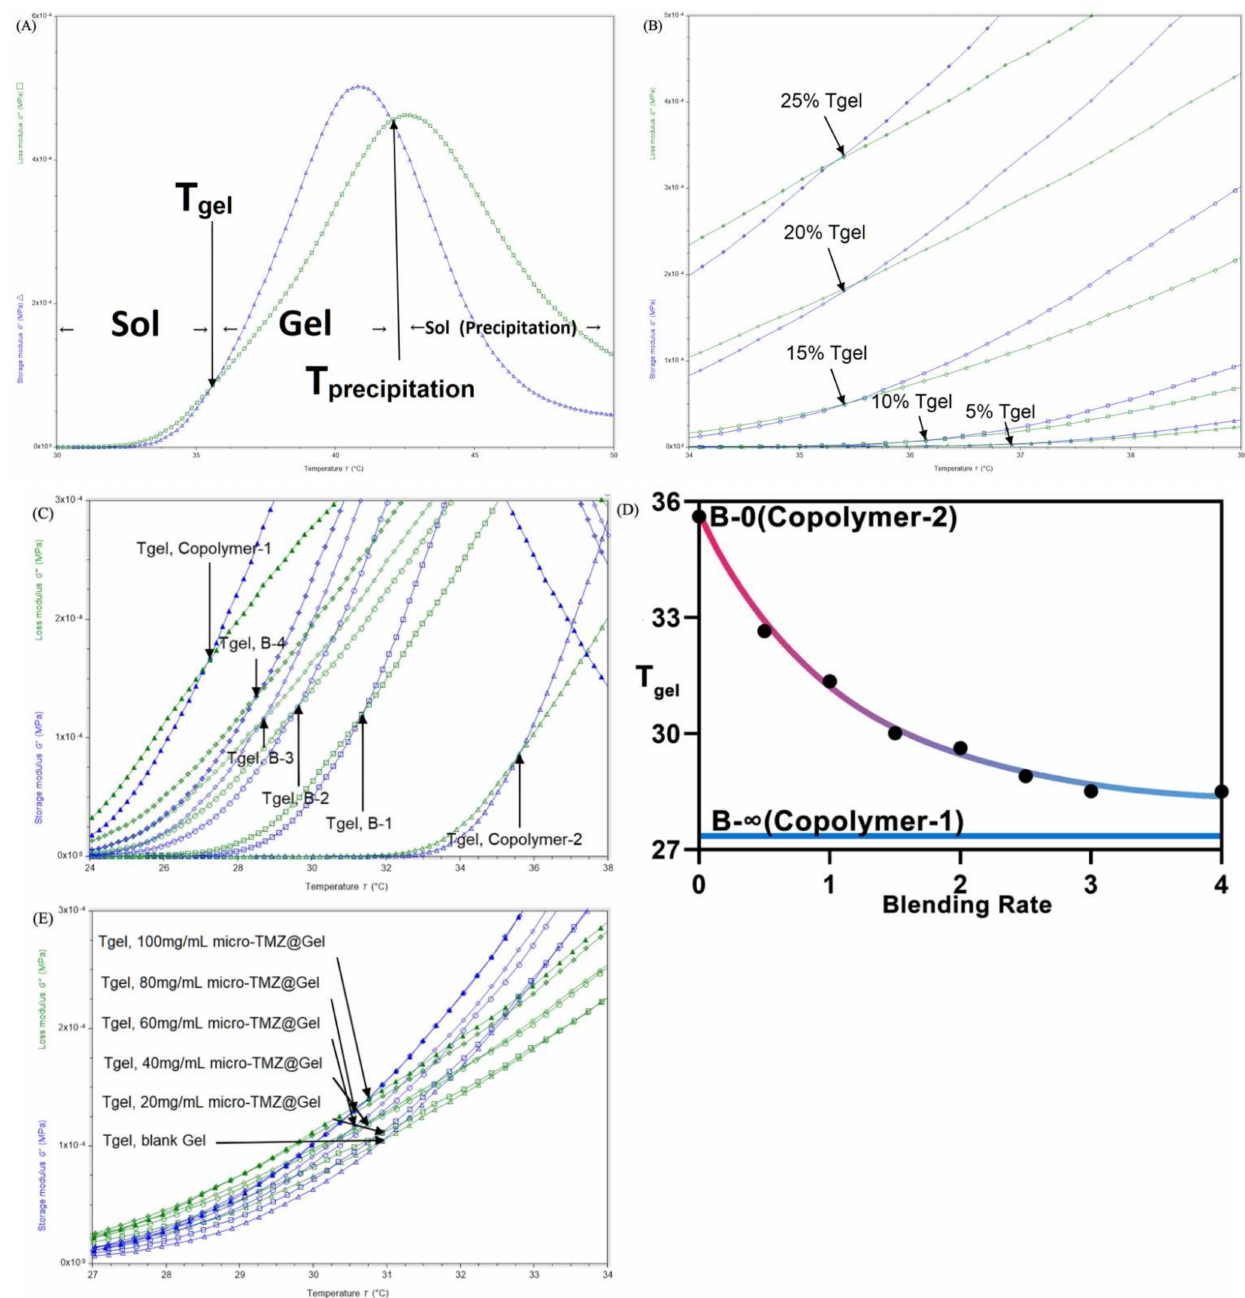
Figure 2. Rheology properties of hydrogel. ( A ) Three phases of PLGA–PEG–PLGA hydrogel in rheology tests. ( B ) Oscillation Temperature Ramp test of Copolymer–2 PLGA–PEG–PLGA